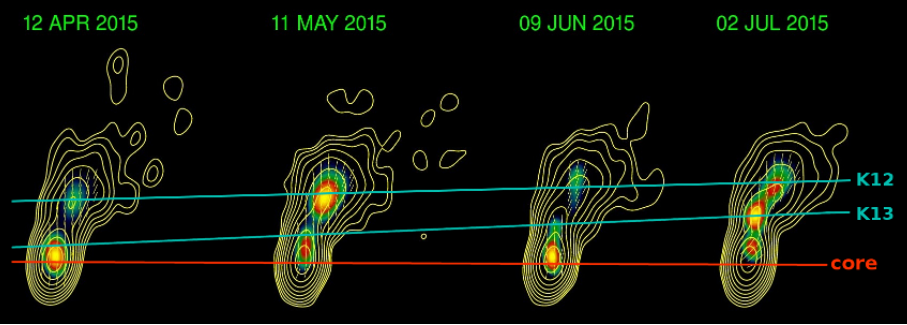
Figure 3. Total (yellow contours) and polarized (color scale) intensity images at 43 GHz; yellow line segments over the color scale show the direction of the electric